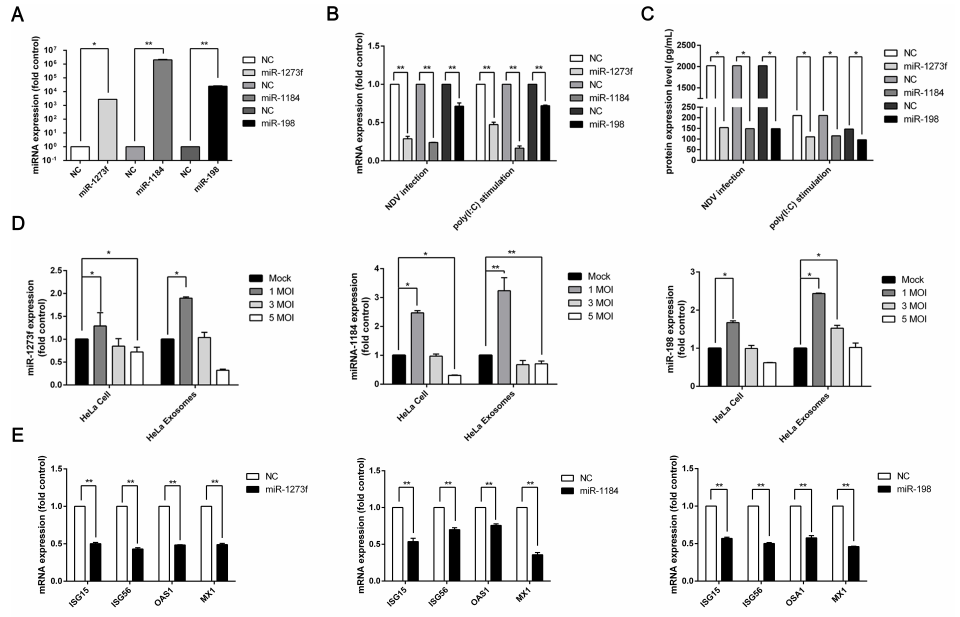
Figure 4. MicroRNAs a ff ect interferon (IFN)- β and interferon stimulated gene (ISG) expression. ( A ) The expression level of three miRNAs in HeLa cells transfected with miRNA mimics was detected by RT-qPCR. ( B ) Three miRNAs (miR-1273f, miR-1184, and miR-198) or negative control miRNA (NC) were transfected into HeLa cells. The HeLa cells were then infected with NDV at a multiplicity of infection (MOI) of 1 or treated with 50 µ g / mL poly (I:C). The IFN- β mRNA level was detected with RT-qPCR. ( C ) Three miRNAs (miR-1273f, miR-1184, and miR-198) or NC were transfected into HeLa cells,